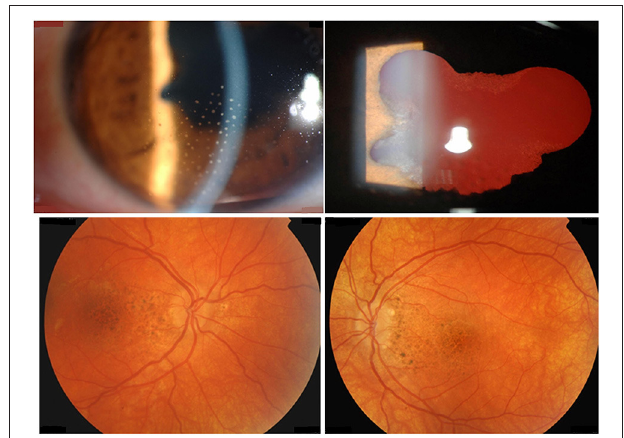
FIGURE 2 | A 39-year-old female with chronic recurrent uveitis associated with Vogt-Koyanagi-Harada disease at presentation. Slit-lamp biomicroscopy shows mutton-fat granulomatous keratic precipitates (first row). Fundus photography shows posterior segment depigmentation resulting in “sunset glow fundus” (second